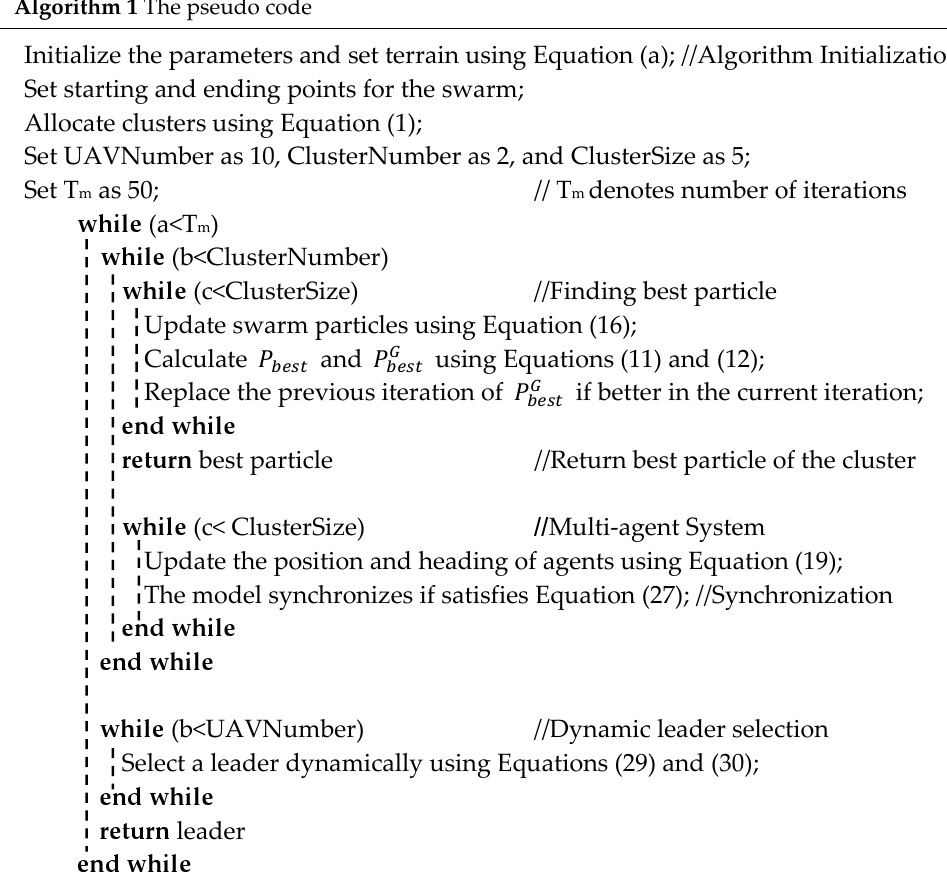
Algorithm 1 The pseudo